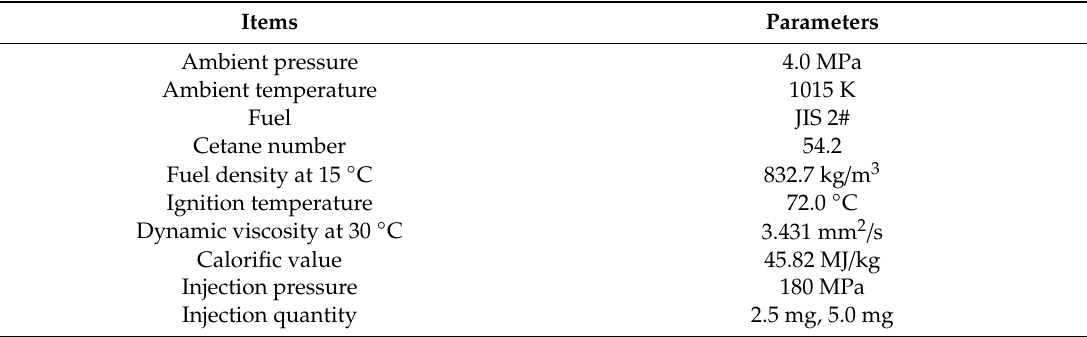
Table 1. Calculation conditions for validation.